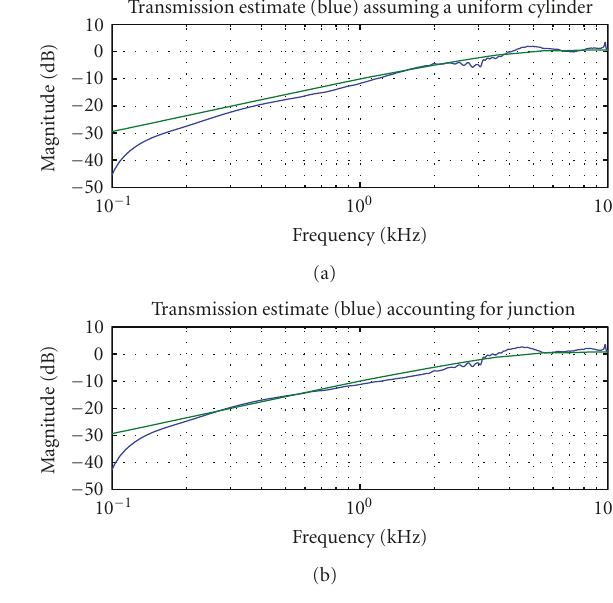
Figure 12: Estimated and theoretical open-end cylinder reflection magnitude as calculated using the ratio of second arrivals (a) according to (14) and by accounting for the discontinuity created by appending a larger radius tube (b) using (17). Notice the latter produces a better fit to the theoretical reflection.